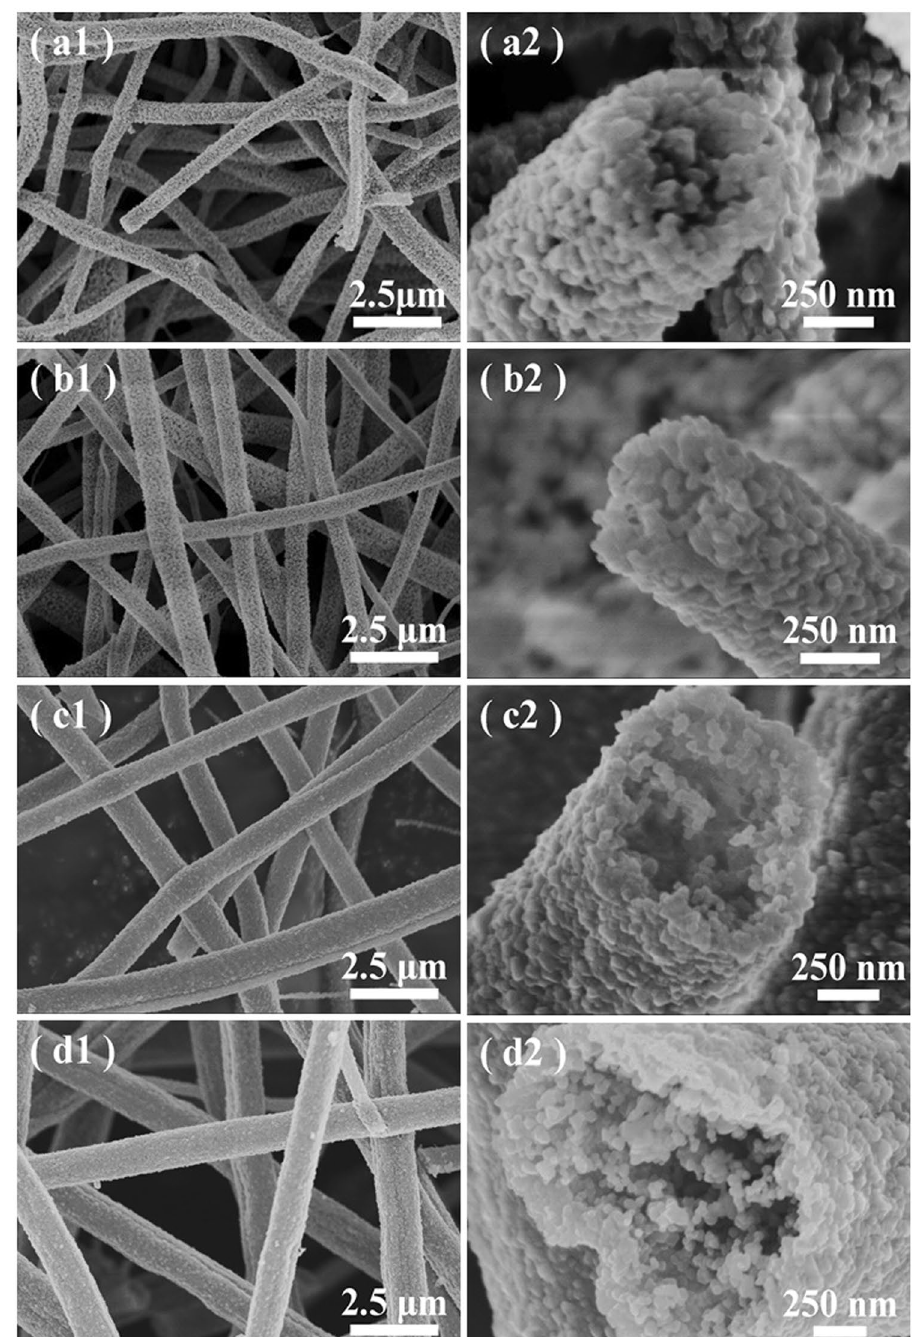
Figure 5. Typical SEM images of pyrolyzed products of Sample A (a1–a2), Sample B (b1–b2), Sample C (c1– c2), and Sample D (d1–d2) under different